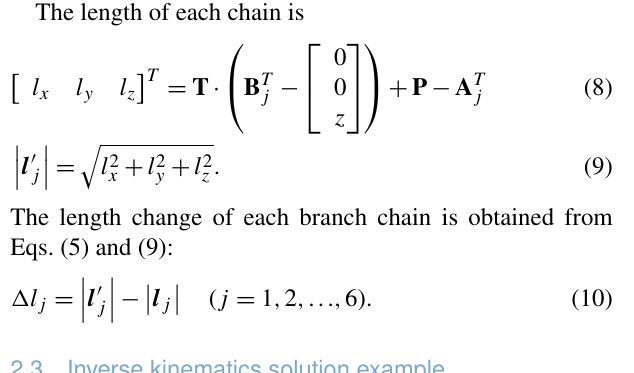
Figure 5. Coordinate system